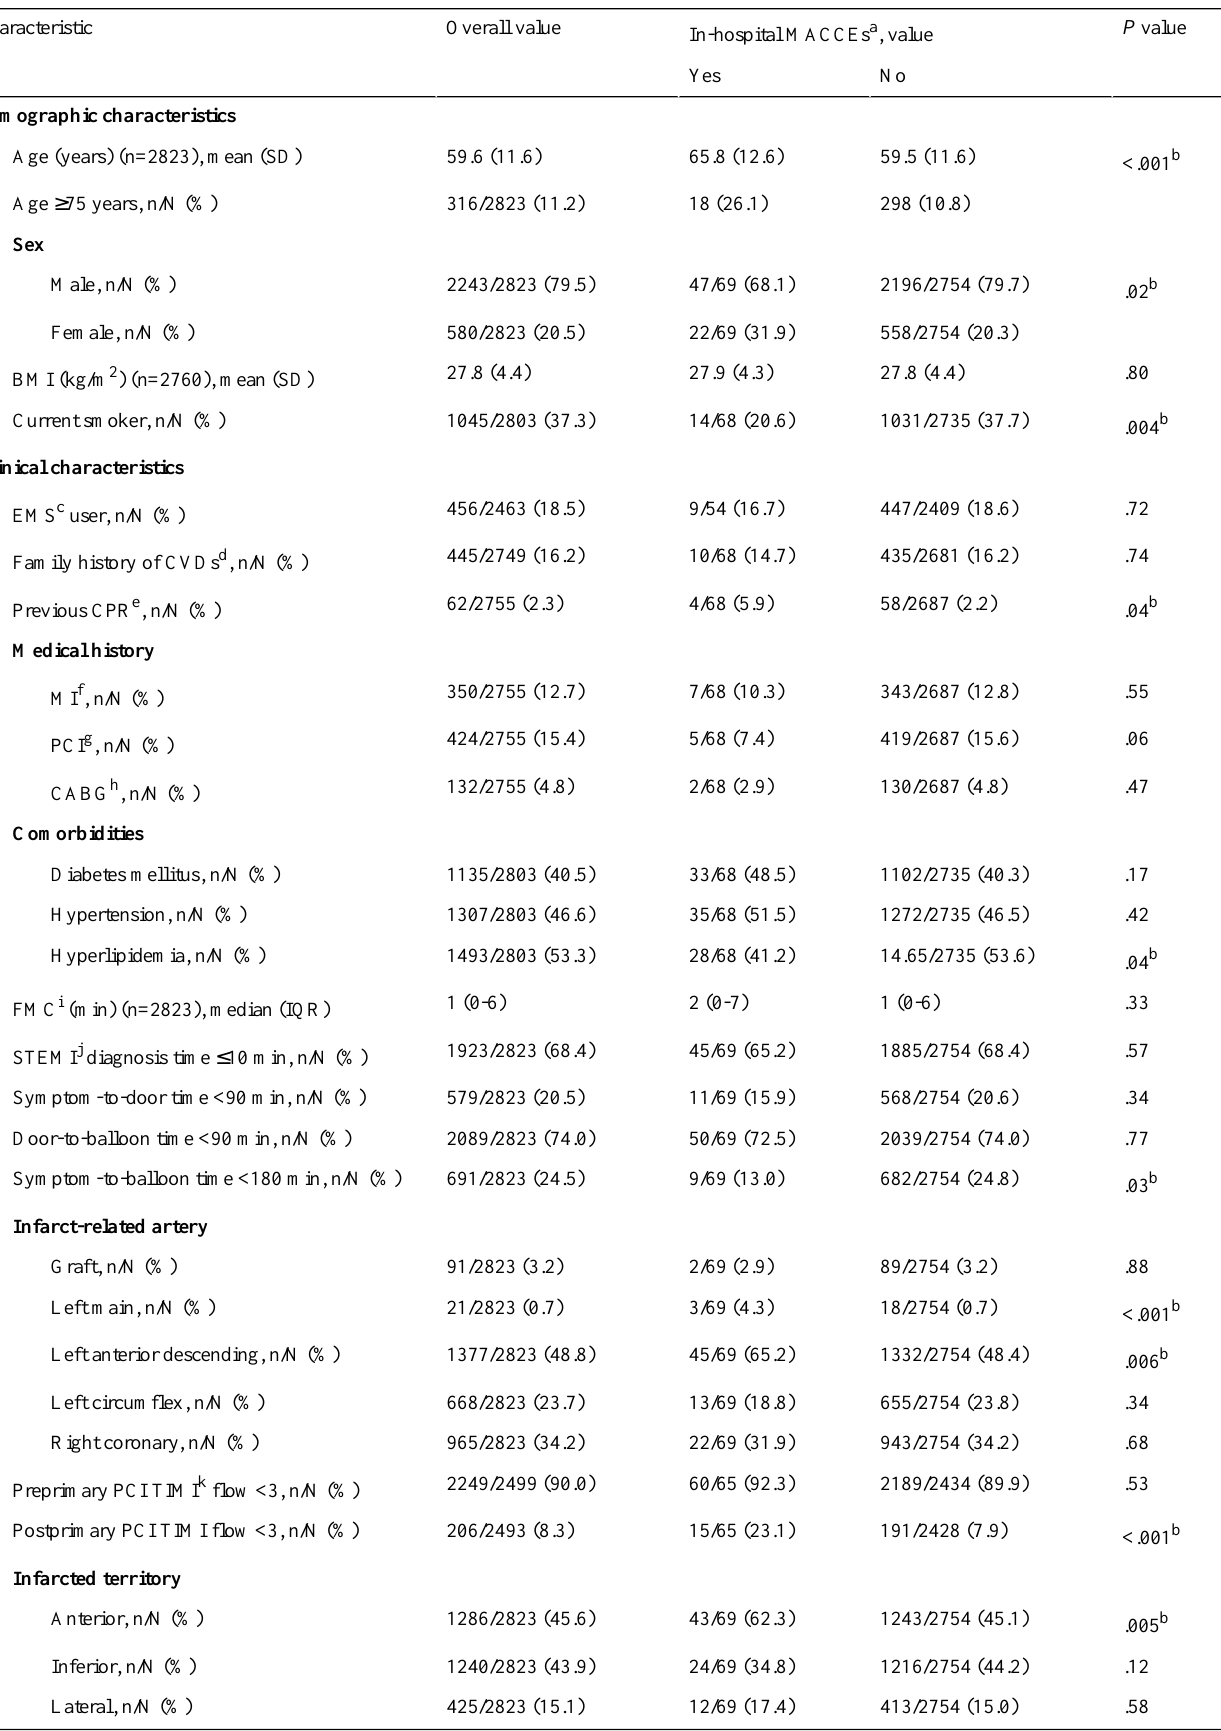
Table 1. Baseline characteristics of the study patients and comparison according to in-hospital major adverse cardiocerebrovascular events.